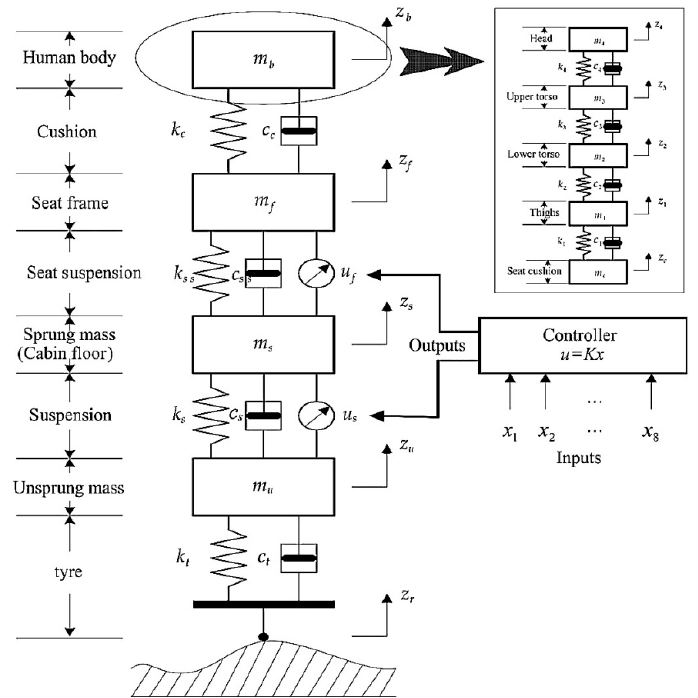
Figure 25. The model of the integral control strategy [72].